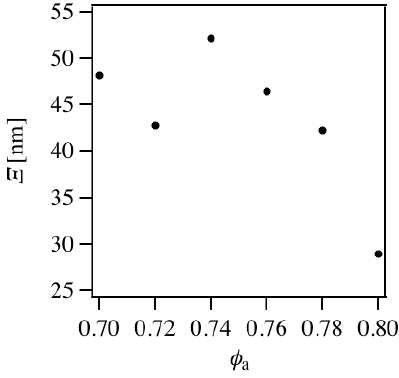
Figure 11. The distance Ξ between aggregated domains as a function of φ a .